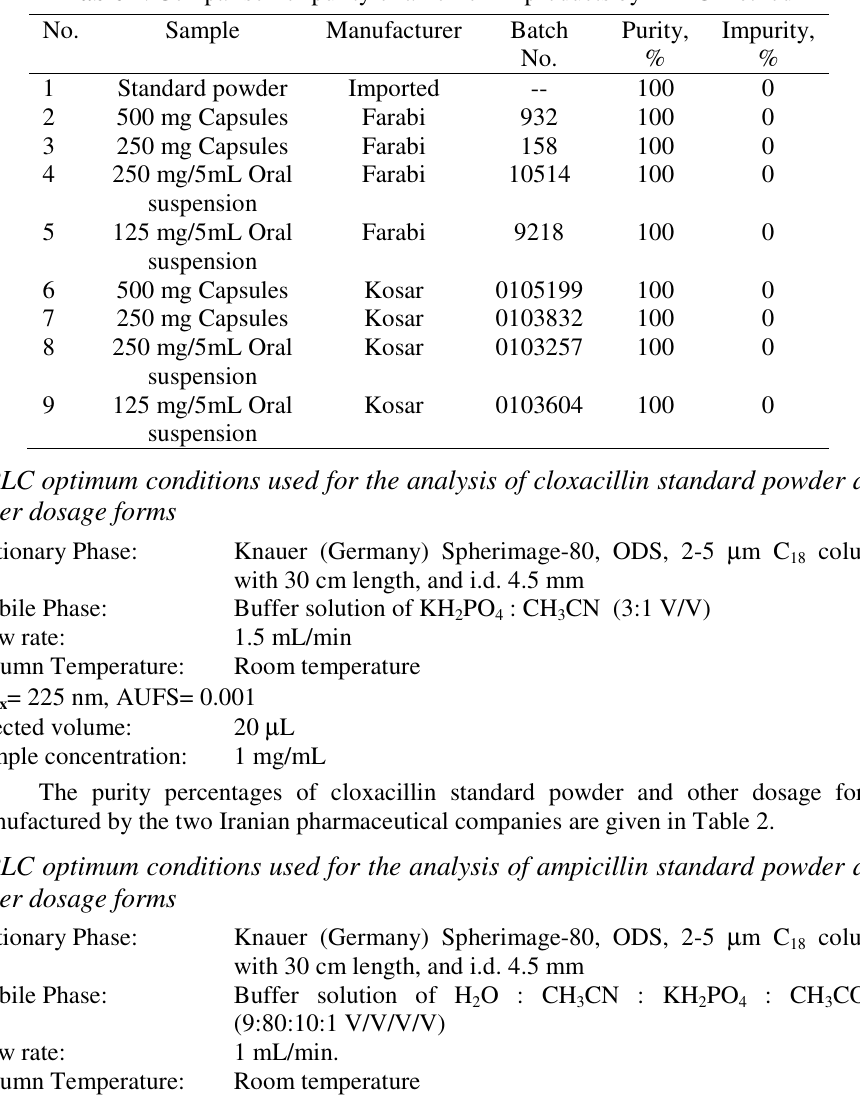
Table 1 . Comparison of purity of amoxicillin products by HPLC